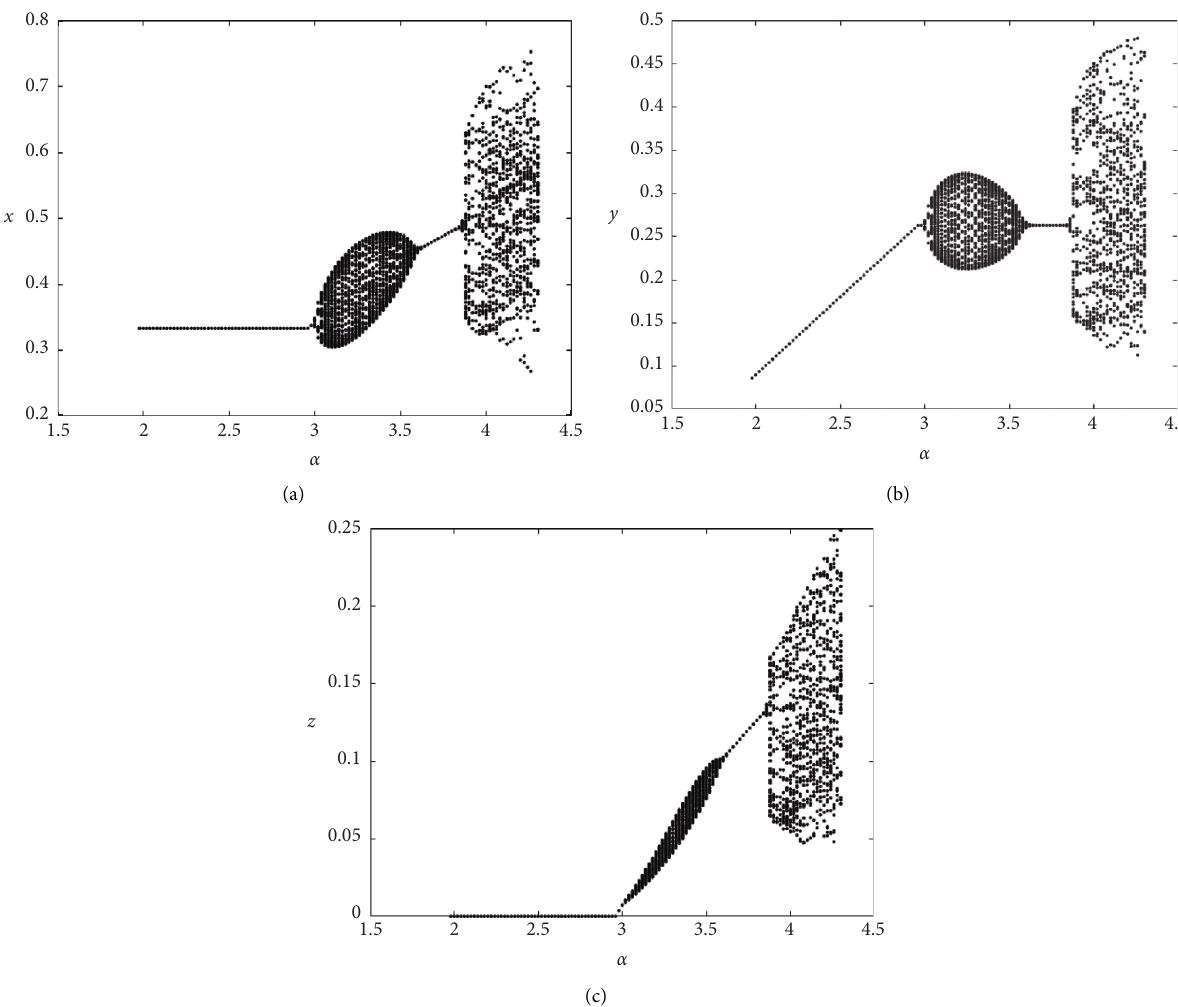
Figure 1: Bifurcation diagrams of equation (5) ( b � 3.7, c � 3, d � 3.5, r � 3.8, and 2 < a < 4.3).